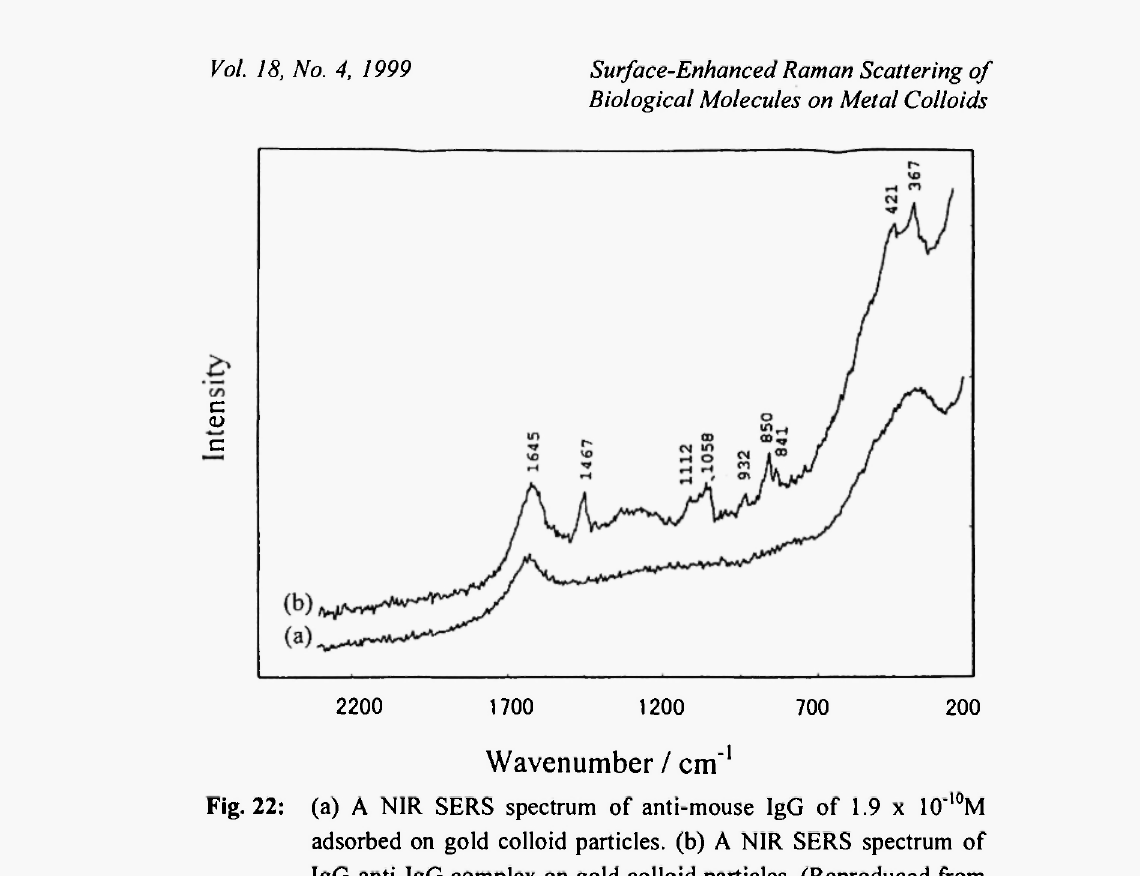
Fig. 22: (a) A NIR SERS spectrum of anti-mouse IgG of 1.9 χ 10"'°M adsorbed on gold colloid particles, (b) A NIR SERS spectrum of IgG-anti-IgG complex on gold colloid particles. (Reproduced from ref. 31 with permission. Copyright (1998) John Wiley & Sons,